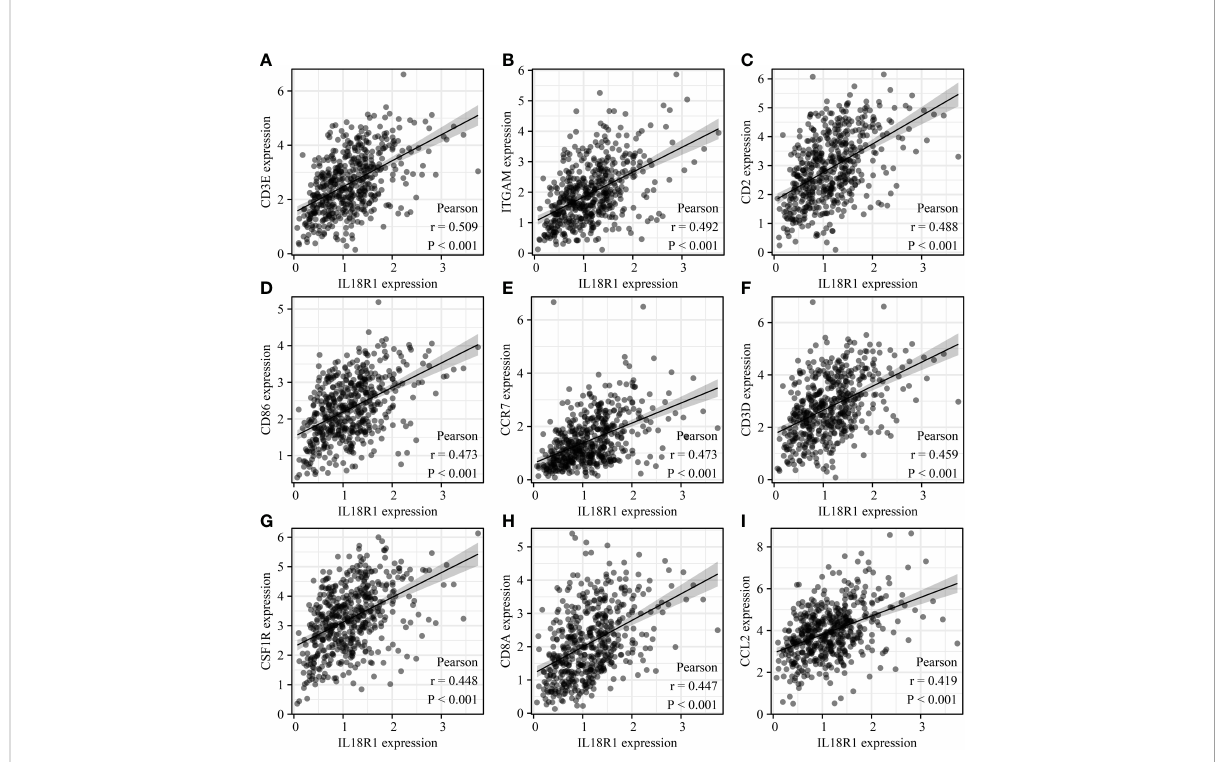
FIGURE 9 IL18R1 was signi fi cantly associated with the levels of immune cell markers in LUSC. (A) CD3E; (B) ITGAM; (C) CD2; (D) CD86; (E) CCR7; (F) CD3D; (G) CSF1R; (H) CD8A; (I) CCL2. LUSC, lung squamous cell carcinoma.